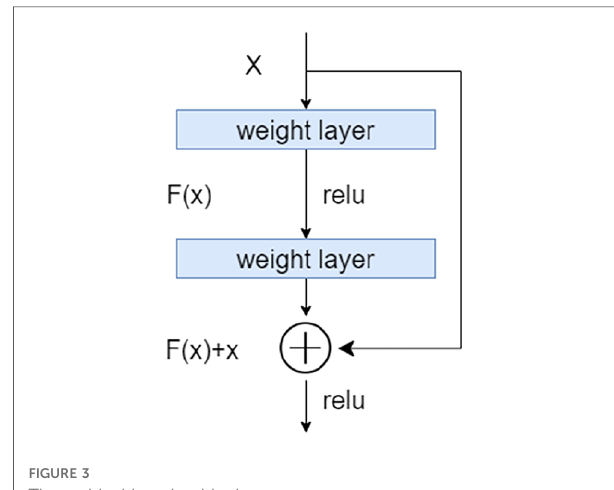
FIGURE 3 The residual learning block.